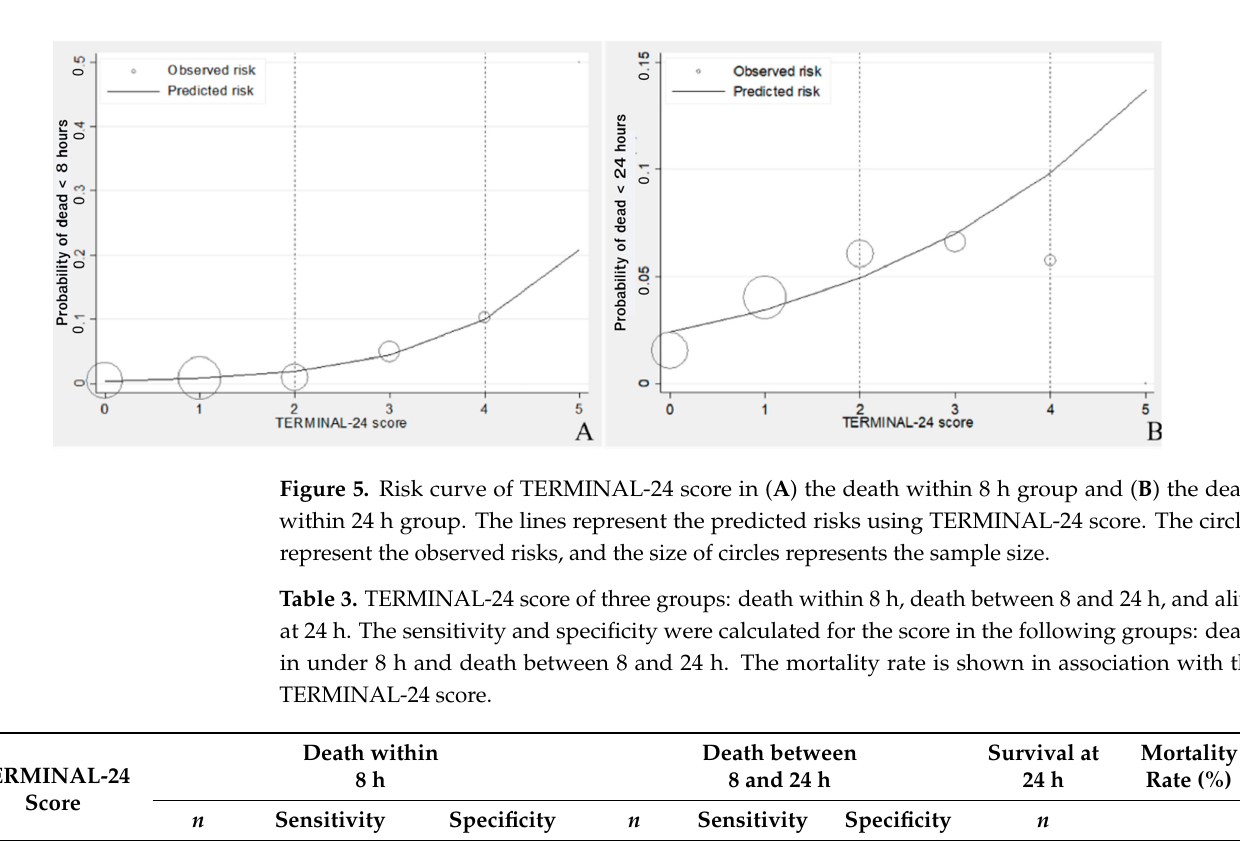
Table 3. TERMINAL-24 score of three groups: death within 8 h, death between 8 and 24 h, and alive at 24 h. The sensitivity and specificity were calculated for the score in the following groups: death in under 8 h and death between 8 and 24 h. The mortality rate is shown in association with the TERMINAL-24 score.